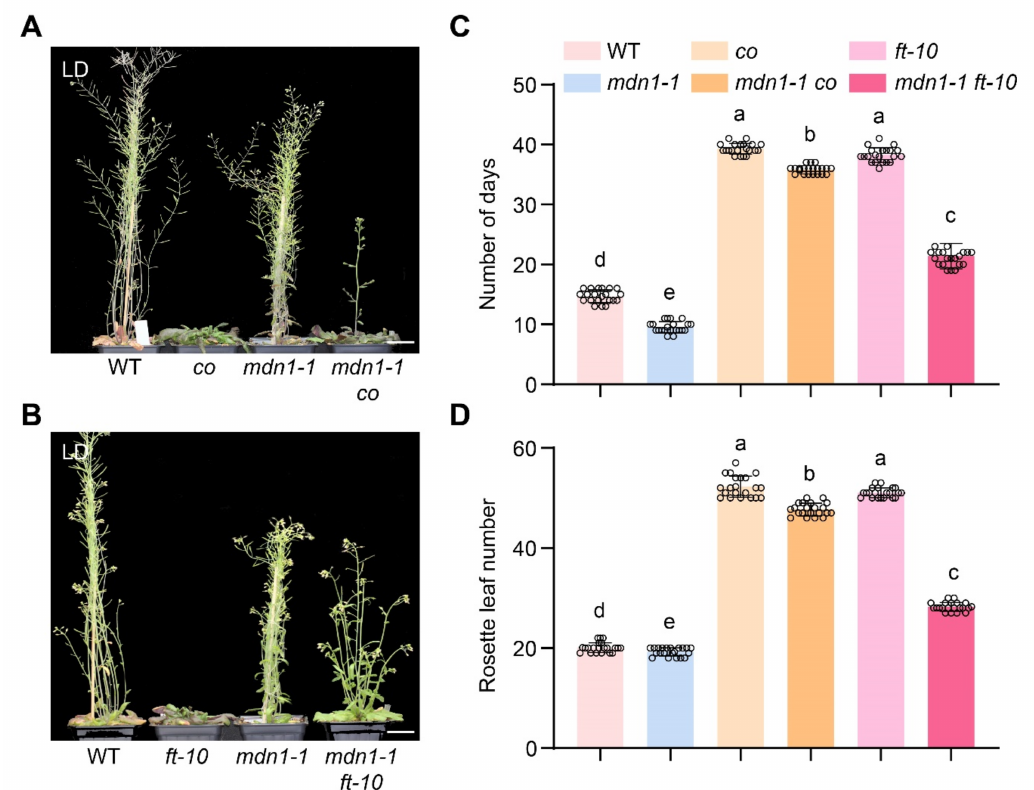
Figure 4. co and ft-10 inhibit the early flowering of mdn1-1 . ( A ) co , mdn1-1 and mdn1-1 co plants grown in LD. ( B ) ft-10 , mdn1-1 and mdn1-1 ft-10 grown in LD. ( C , D ) The number of days and rosette leaf number at the flowering in LD. Twenty plants per line were scored. One-way ANOVA was employed, and the lowercase letters denote distinct groups ( p < 0.01). Scale bars, 2 cm. In the clf-28 plant, the expression of FLC and FT is de-repressed, while the overex- pression of FT bypasses the FLC-dependent pathway, which results in an early-flowering phenotype in the clf-28 plant [35]. We introduced clf-28 mutation into the mdn1-1 mutant background. mdn1-1 clf-28 double mutant flowered earlier than mdn1-1 , but later than clf-28 under LD conditions. This observation further supports the above hypothesis (Figure 5).